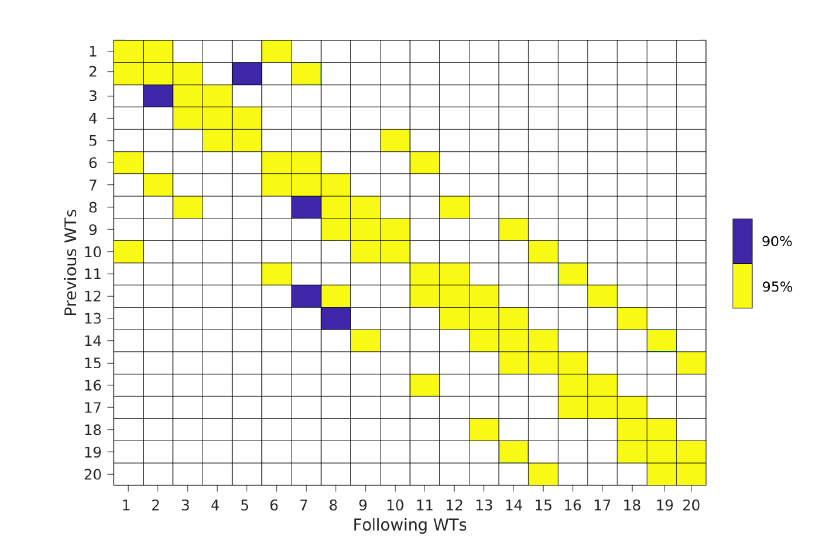
Figure 5. As Figure 4, except for significance of transitions between weather types, calculated at the 90 and 95% levels of